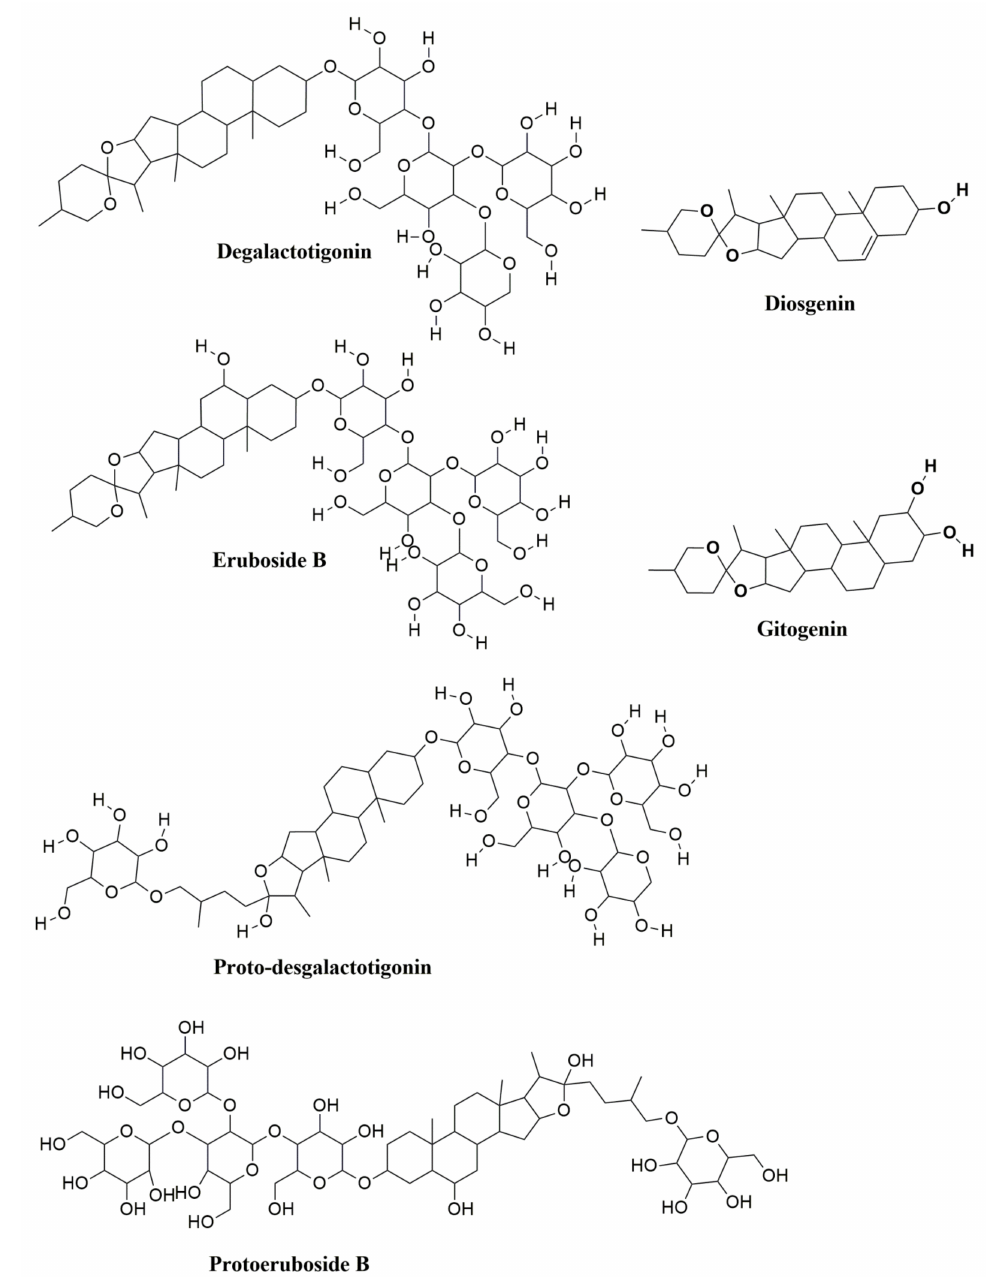
Figure 10. The bioactive compounds from Allium sativum (garlic) and their chemical